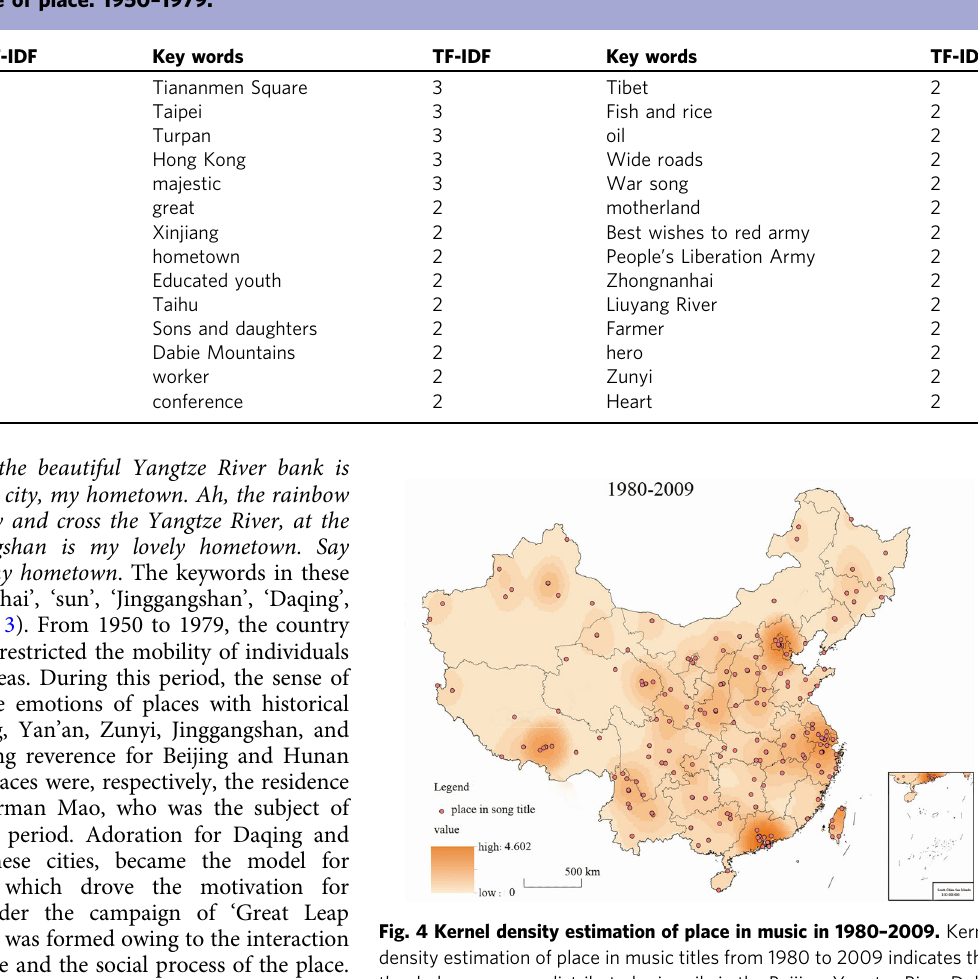
Table 3 Keywords of sense of place: 1950 – 1979.